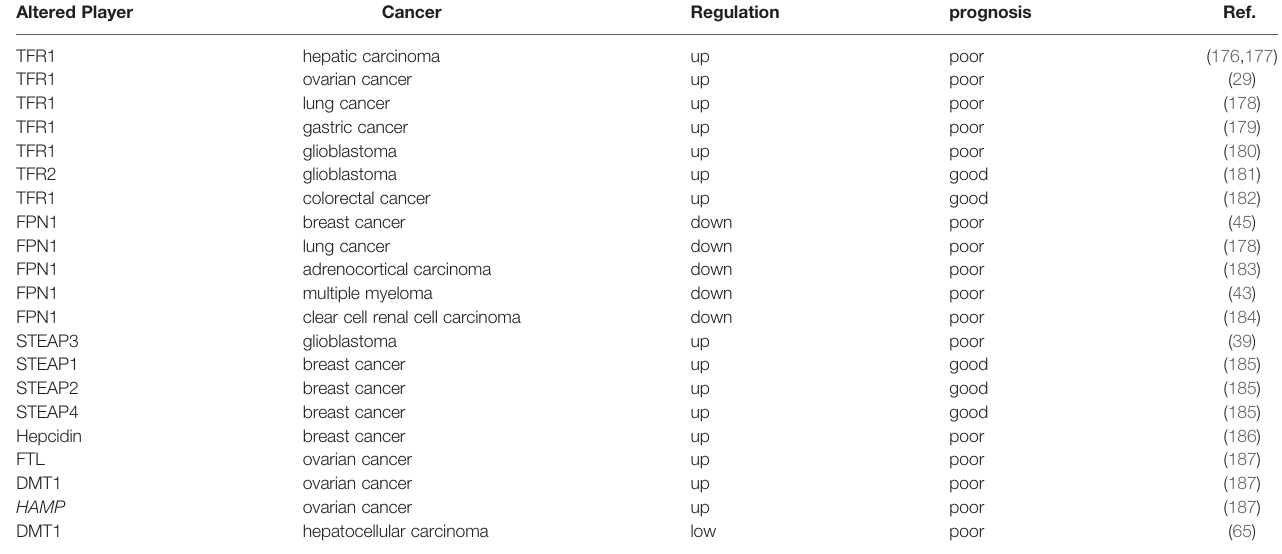
TABLE 2 | Iron regulators in cancer